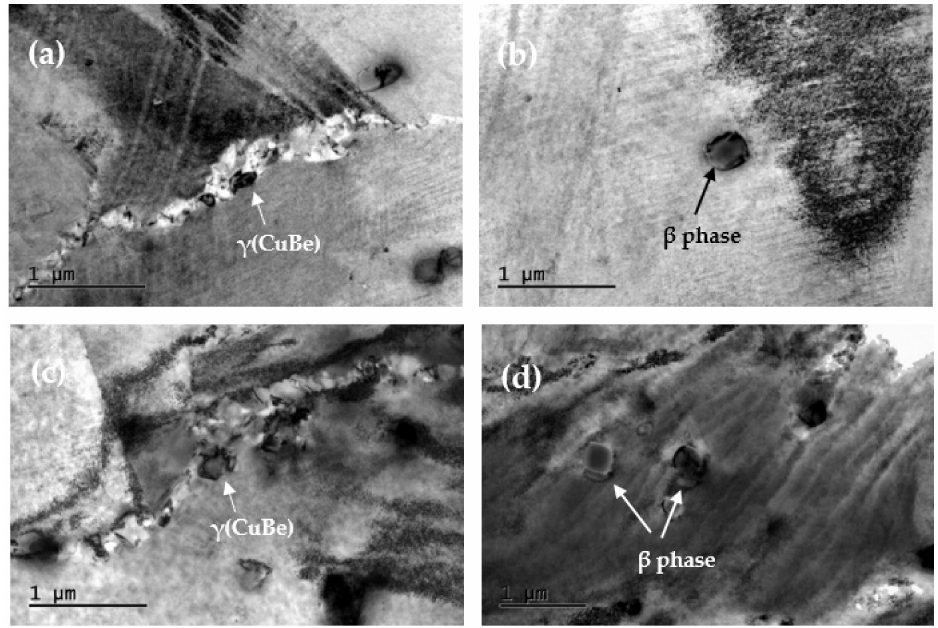
Figure 6. TEM images of alloys at the peak aging. ( a ) γ phase of C17200; ( b ) β phase of C17200; ( c ) γ phase of QBe2.0; ( d ) β phase of